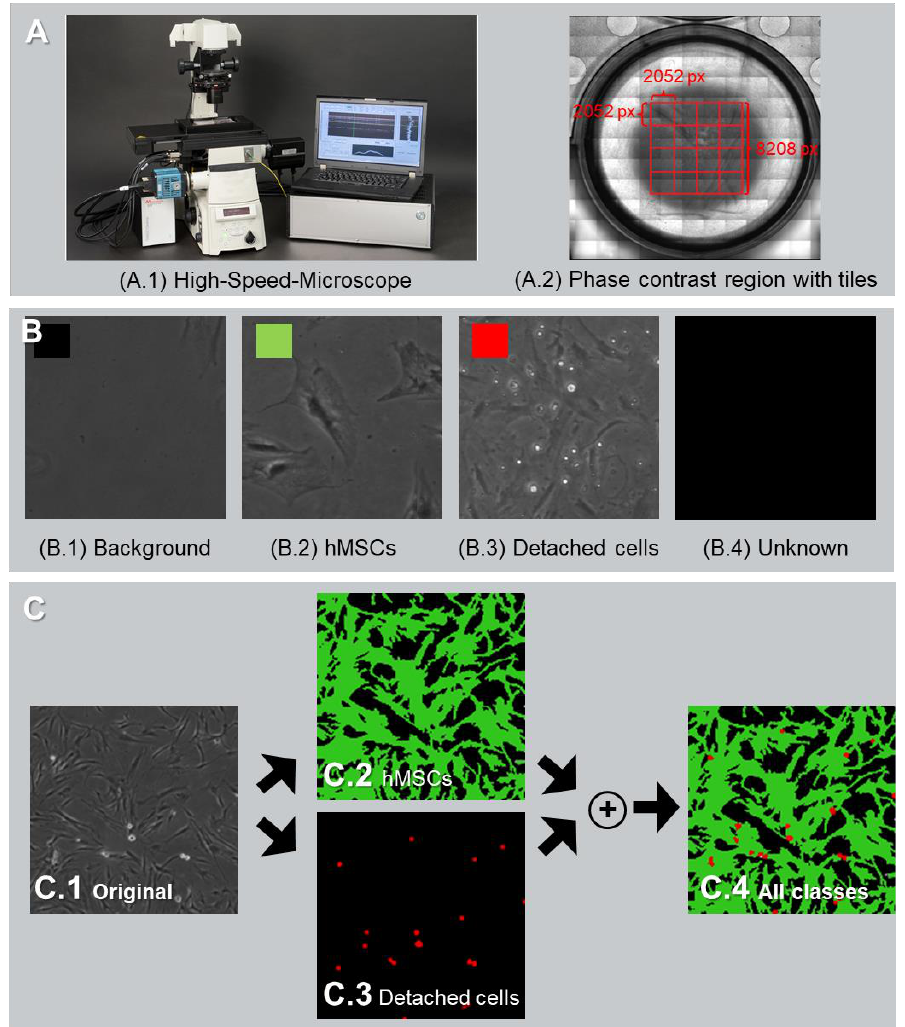
Figure 4. ( A ) High-speed microscope [10]: ( A.1 )and a representative image of one well of a six-well culture plate ( A.2 ) with a description of the phase contrast region. ( B ) Classes defined for training: ( B.1 ) background, ( B.2 ) human mesenchymal stem cells (hMSCs), ( B.3 ) detached cells, ( B.4 ) unknown. ( C ) Generation of the segmentation mask for deep learning: ( C.1 ) original image, ( C.2 ) foreground segmentation using Phantast, ( C.3 ) detached cells segmentation, ( C.4 ) combination of the classes MSC, detached cells and background.